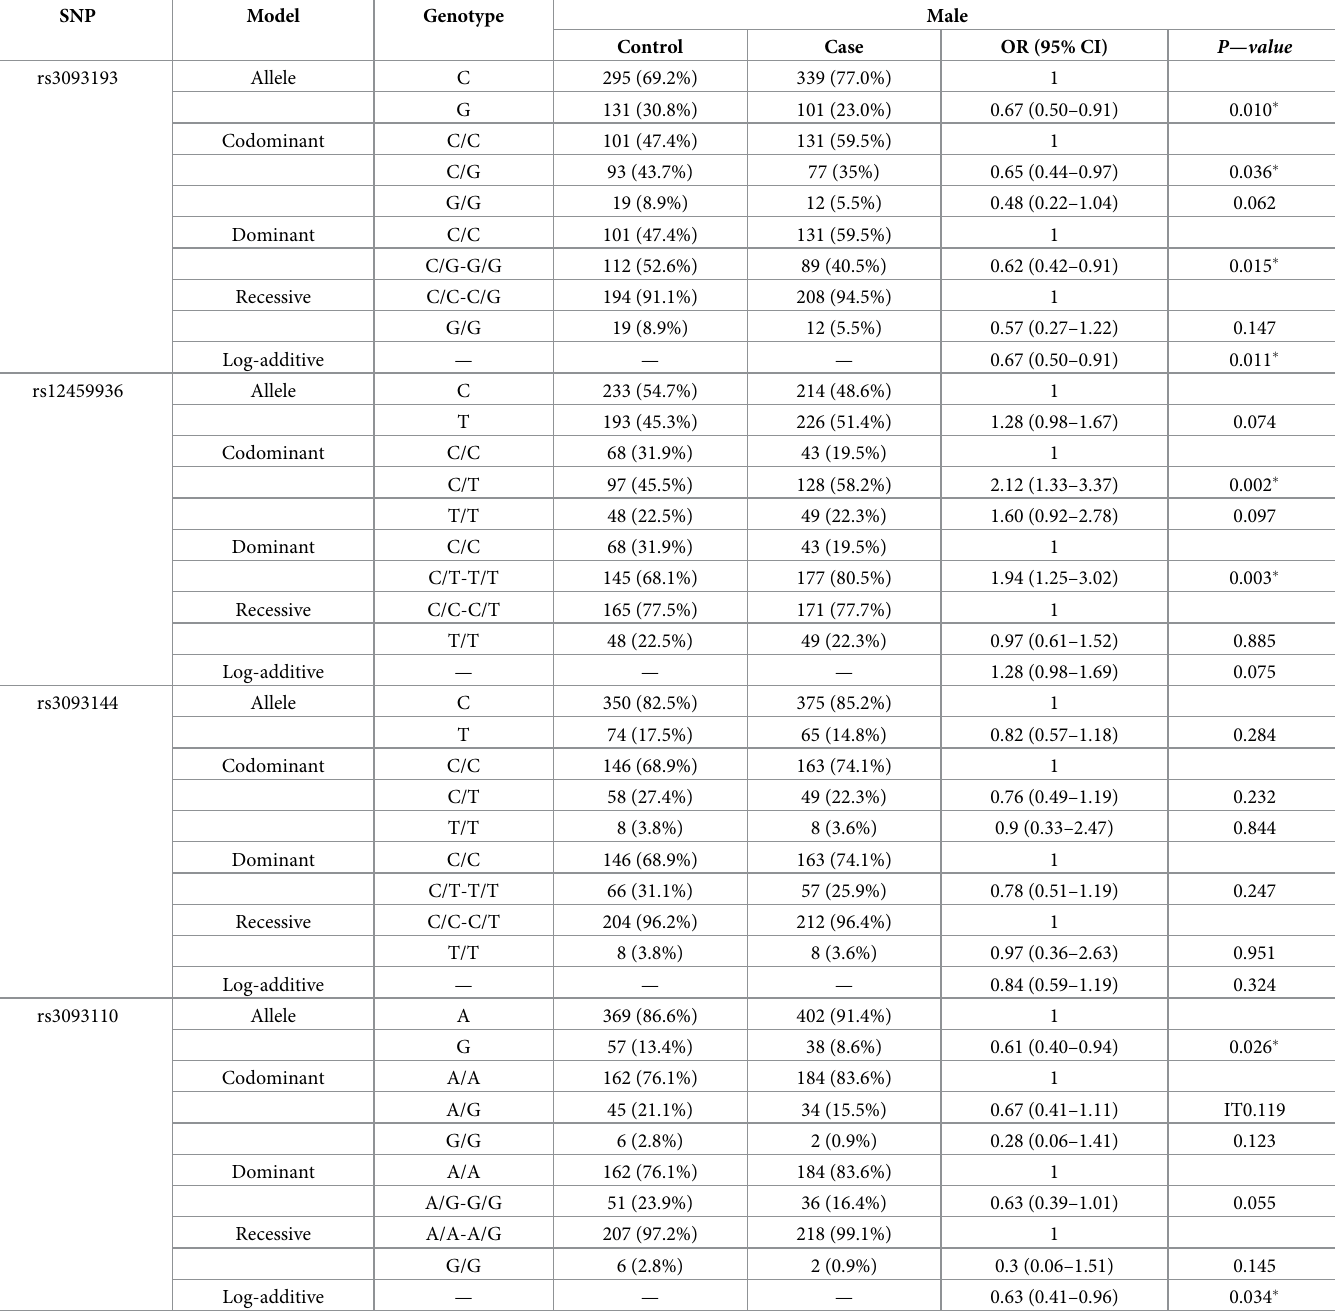
Table 7. Association between CYP4F2 gene polymorphisms and HAPE risk in